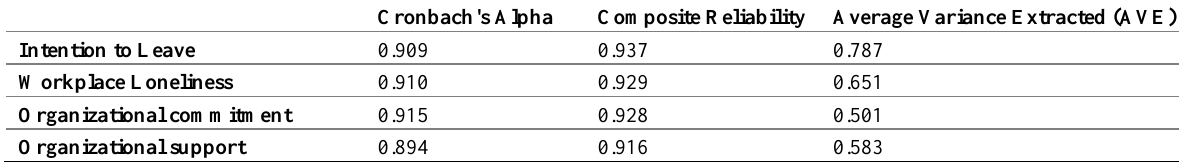
Table 4: Composite Reliability